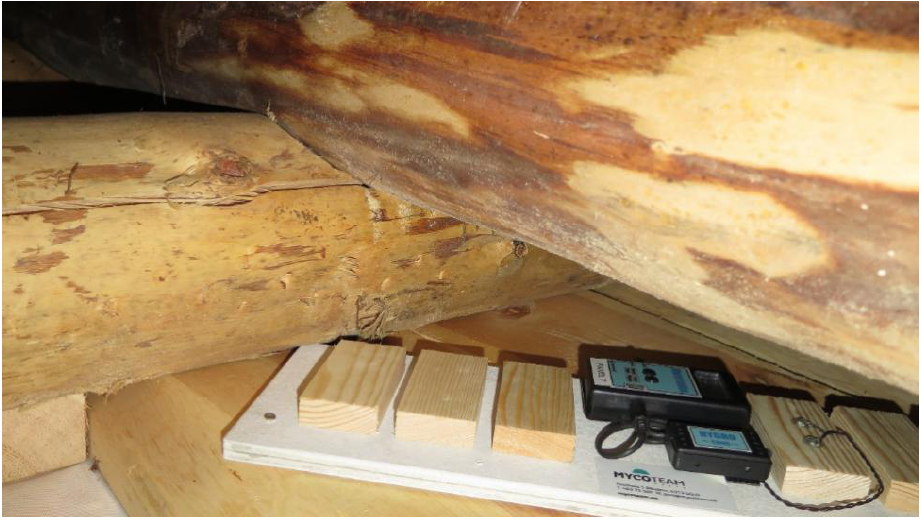
Figure 3. Climate panel. Photo: NIKU.